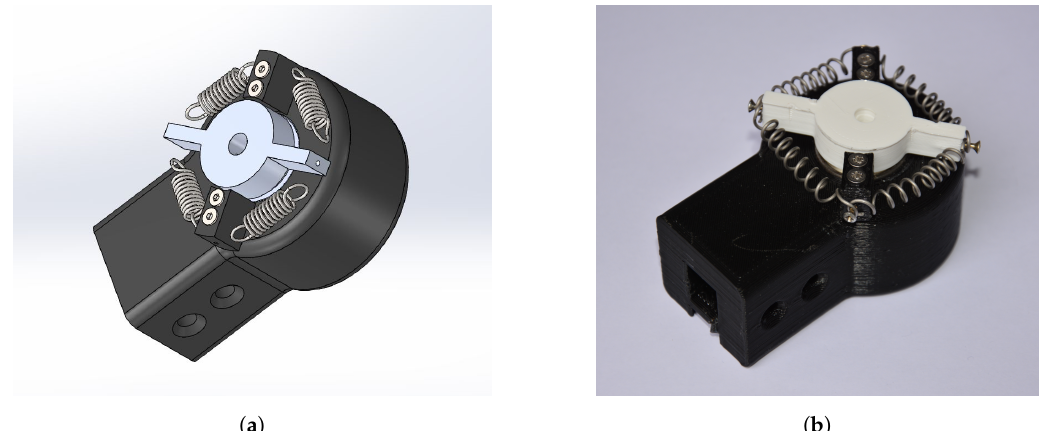
Figure 1. CAD representation and real joint (v1). ( a ) 3D render of joint (previous version (v1)); ( b ) Real joint (previous version (v1)).